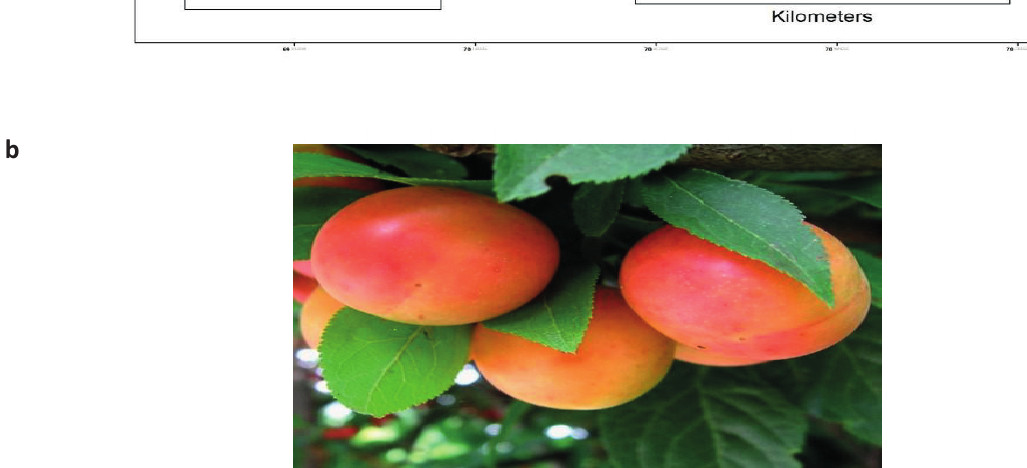
drying at 120 in oven for 2 h [11]. Obtained products were calcinated at two temperatures i.e., 200 and 400 ℃ for 2 h for obtaining PZO NFs furnace (D550, Ney Vulcan, USA) [12]. Calcined white powder was further ground with pestle and mortar for characterization.